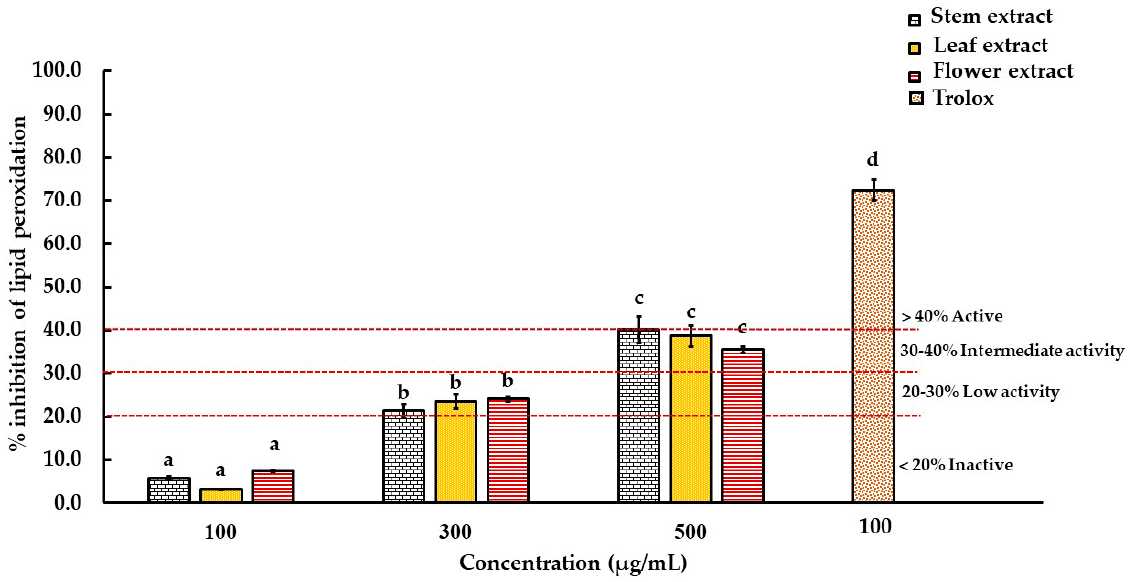
Figure 2. Anti-lipid-peroxidation activities of D. sulcatum ethanolic extract from stems, leaves and flowers (at the final concentration of 100, 300 and 500 µ g/mL) using thiobarbituric acid reactive substances (TBAR) assay. Each value represents the mean ± SD ( n = 3). The different letters are significantly different ( p < 0.05) according to Tukey’s HSD test. The last column depicts Trolox (100 µ g/mL) which was used as the positive control. Samples exhibiting <20% inhibition were considered inactive, 20–30% inhibition was low activity, >30–40% inhibition was moderate activity and >40% was considered as active [26].